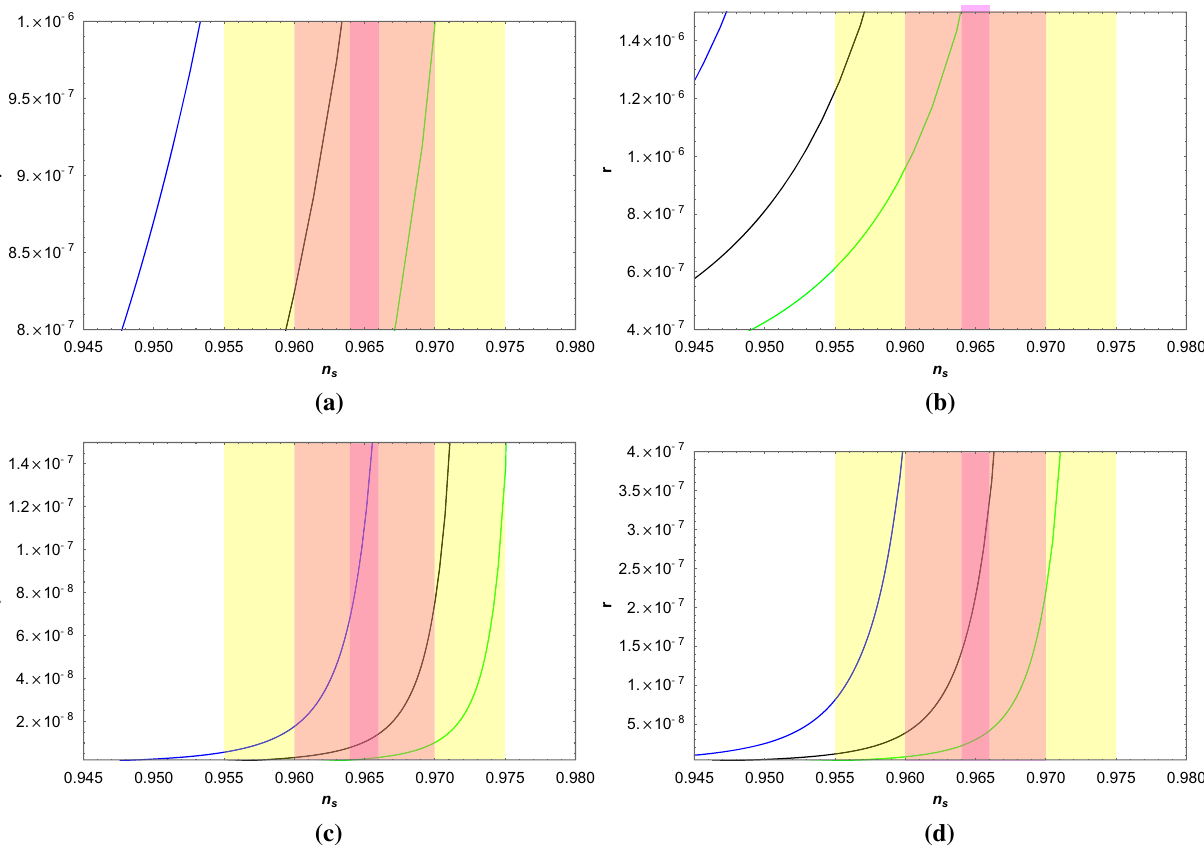
Fig. 3 Plots of r and n s as a function ρ 0 for fixed values of V 0 = 10 8 GeV. In a n = 1 , q = 3 and m = 10 − 6 , b n = 2 , q = 3 and m = 10 − 3 , c n = 3 , q = 3 and m = 10 − 3 and in d n = 4 , q = 3 and m = 10 − 3 . The blue line corresponds to N e = 55, the black line corresponds to N e = 65, the green line corresponds to N e = 75 .